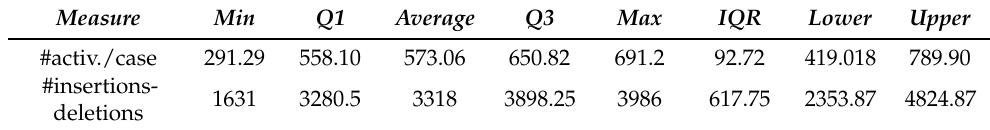
Table 3. Tukey’s method to detect